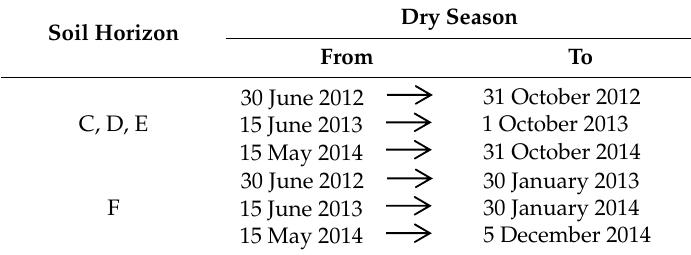
Table 4. Time spans of dryseasons for the various investigated layers.